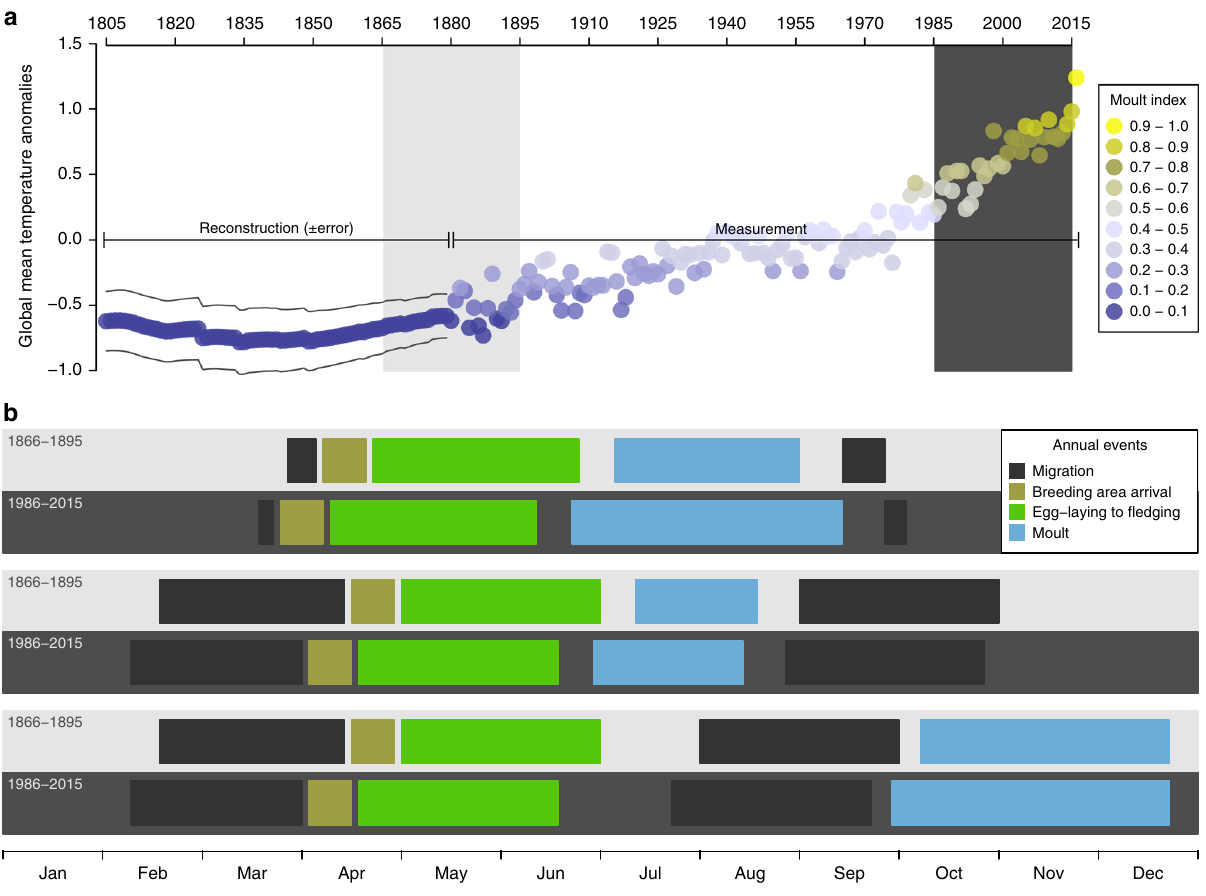
Fig. 2 Passerine moult extent and phenological changes associated with global warming. a Global mean temperature anomalies (GMTA) trend since 1805 and bird feather moult extent. The moult index represents the relative extent of moult that was found in the study, averaged per year among all study species, such that the lowest relative extent of moult = 0 and the highest relative extent of moult = 1. Light grey and dark grey shaded areas represent two periods that are referred to in b. b Phenological changes in avian annual routine events over the last two centuries. Upper two rows (light grey = earlier years, dark grey = recent years): residents and short-distance migratory species – advancement of spring arrival and breeding, delayed autumn migration and shortened migration distance causing a longer moulting period and resulting in a more extensive moult. Middle two rows: Long-distance migratory species with pre-migration moult – advancement of spring arrival and breeding causing a longer moulting period, also resulting in a more extensive moult. Lower two rows: Long-distance migratory species with post-migration moulting period – it is suggested that advancement of the autumn migration combined with earlier arrival to the wintering areas and richer food resources in the northern Afrotropical Sahel zone after the summer rains allow these birds to moult more extensively. The changes in the timing of annual routine events are largely based on data from different published studies 3 –